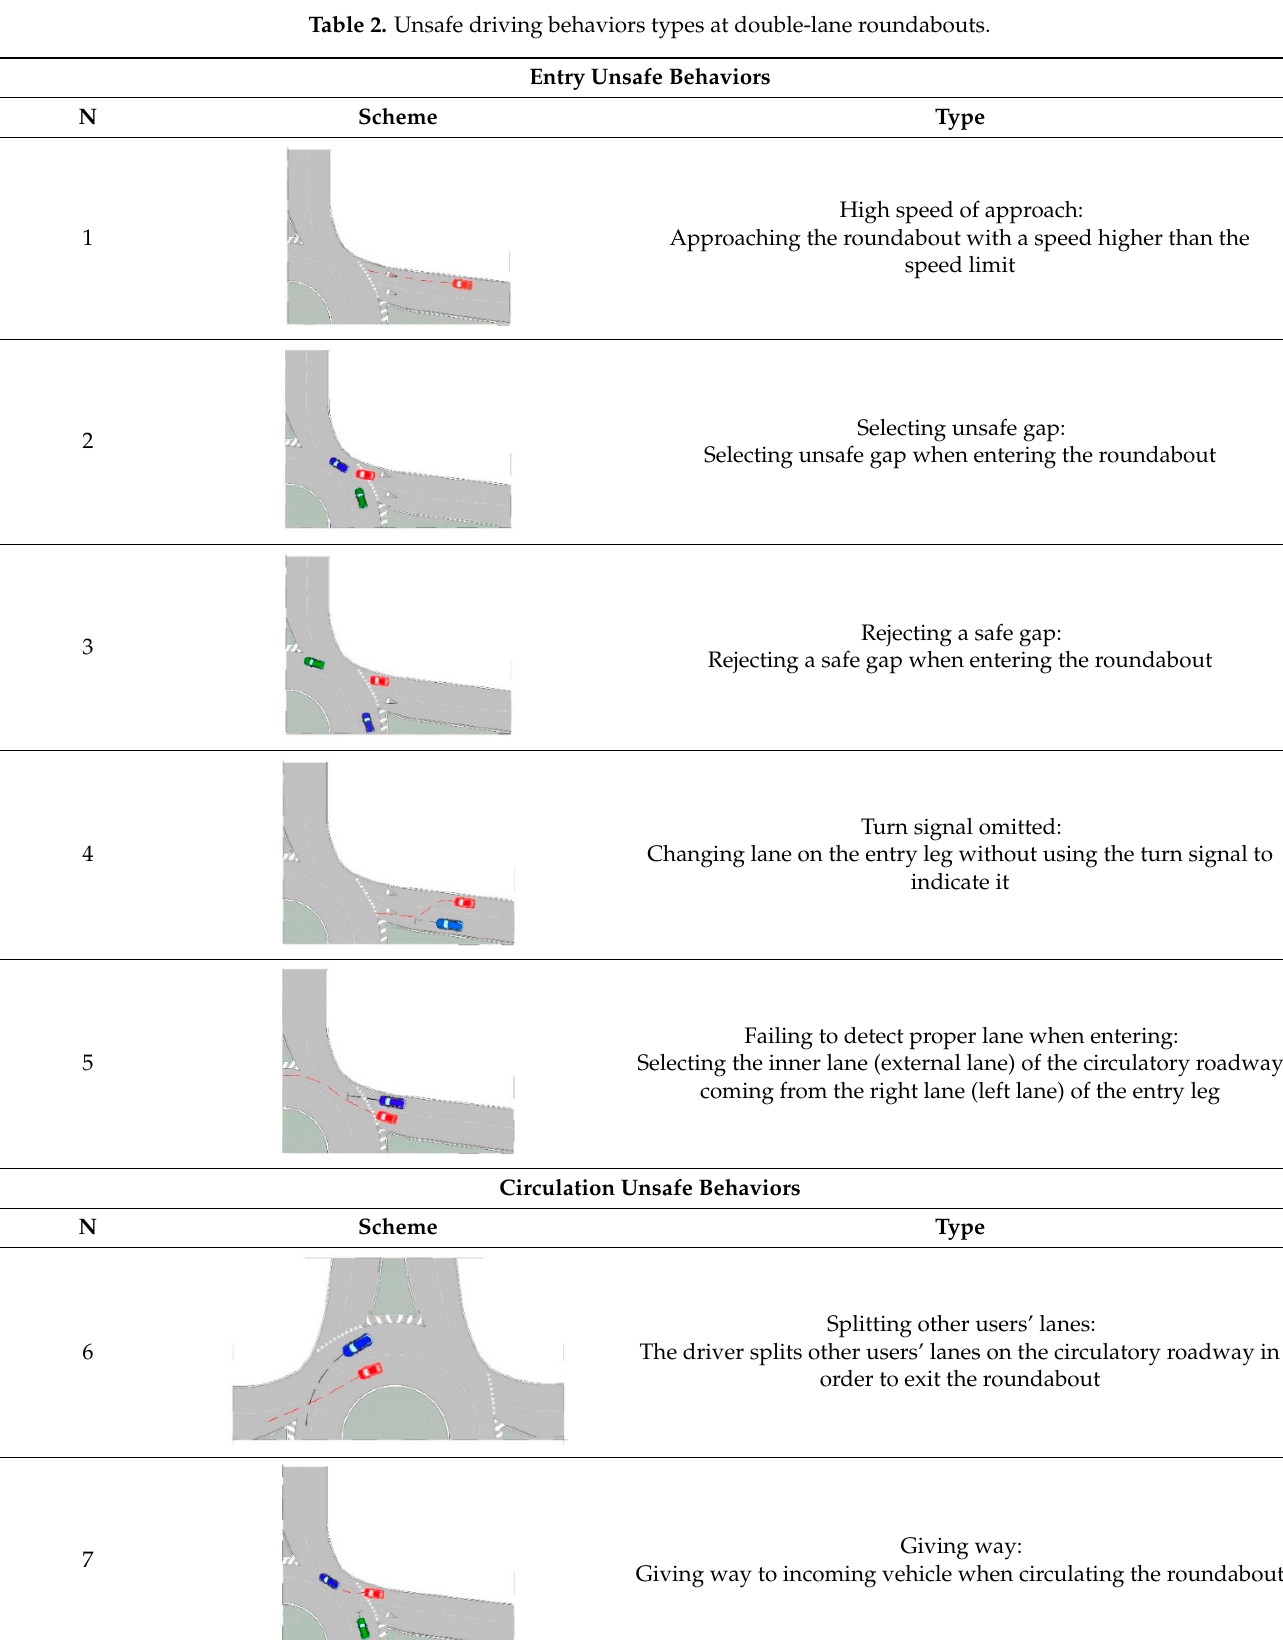
Table 2. Unsafe driving behaviors types at double-lane roundabouts.